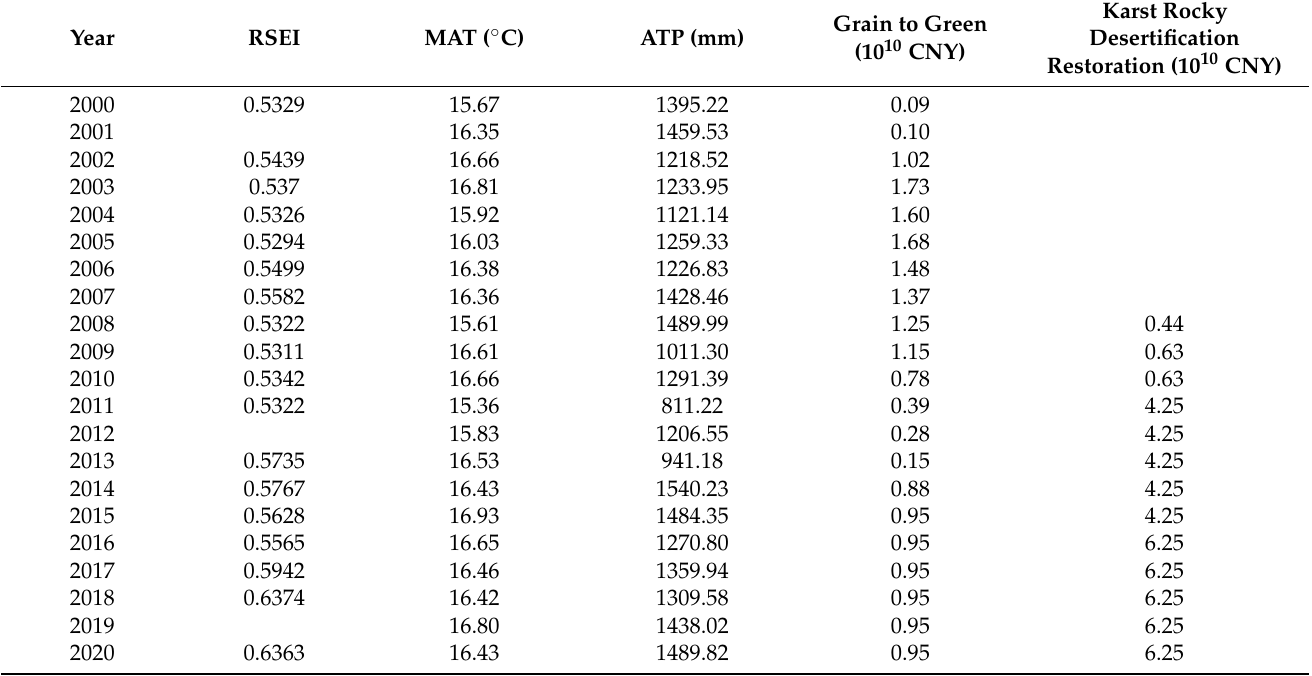
Table A1. Statistical table of changing EEQ image